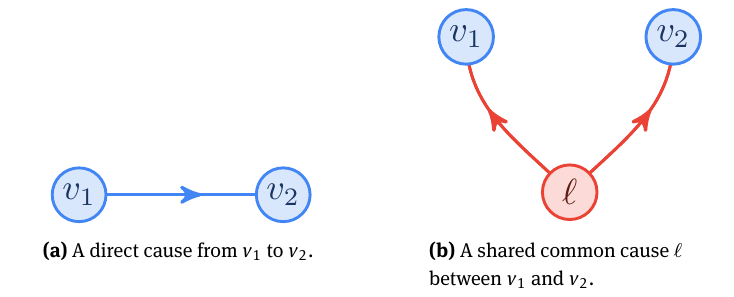
Figure 17: The causal structures of (a) and (b) are observationally